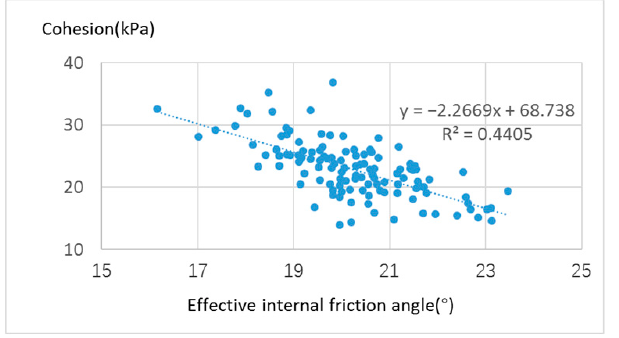
Figure 4. Scatter plot of cohesion and its influencing factors.